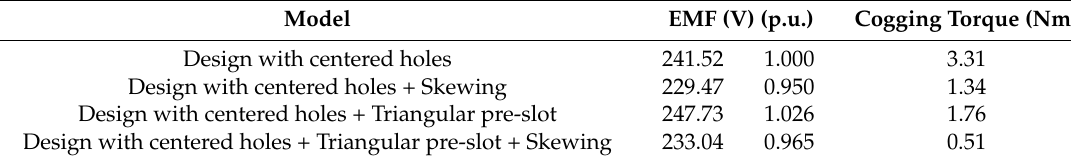
Table 5. Comparison of the electromotive force (EMF) and cogging torque values of PMSG with centered holes and the different models considering skewing.